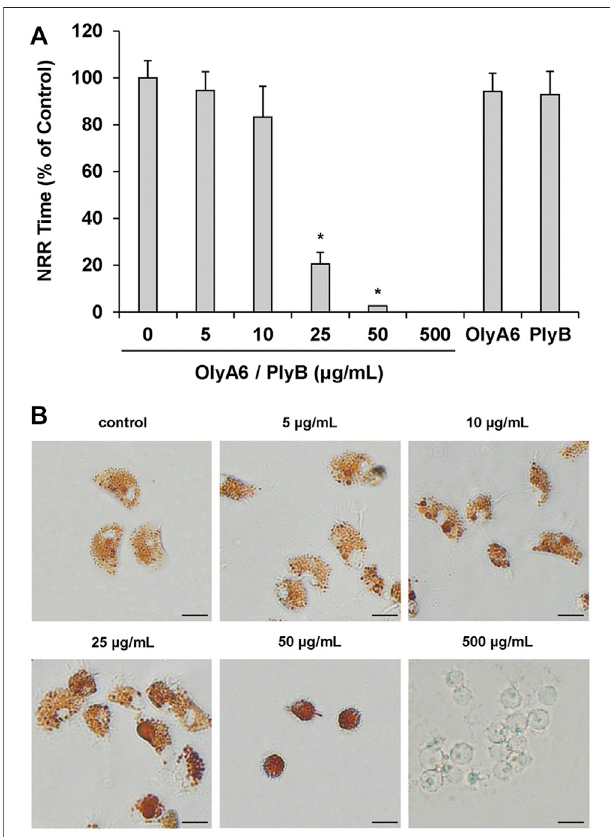
FIGURE 6 | Effects of the OlyA6/PlyB mixture on lysosomal membrane stability of M. galloprovincialis hemocytes. Hemocytes were exposed to different concentrations of the mixture (5, 10, 25, 50, 500 μ g/ml; OlyA6/PlyB molar ratio 12.5/1) and to OlyA6 (25 μ g/ml) or PlyB alone (2 μ g/ml). (A) Data, reported as percent values of neutral red retention time with respect to controls, representing the mean ± SD of four experiments in triplicate, were analysedbytheMann Whitney U test. * p < 0.01. (B) Representativeimagesof hemocytes treated with different concentrations of the protein mixture, as indicated. NRR – neutral red retention time. Scale bar = 10 μ m.